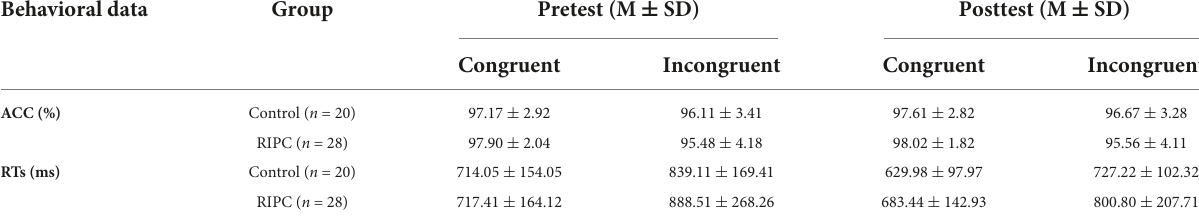
TABLE 1 The raw behavioral data in pretest and posttest of control and RIPC group.